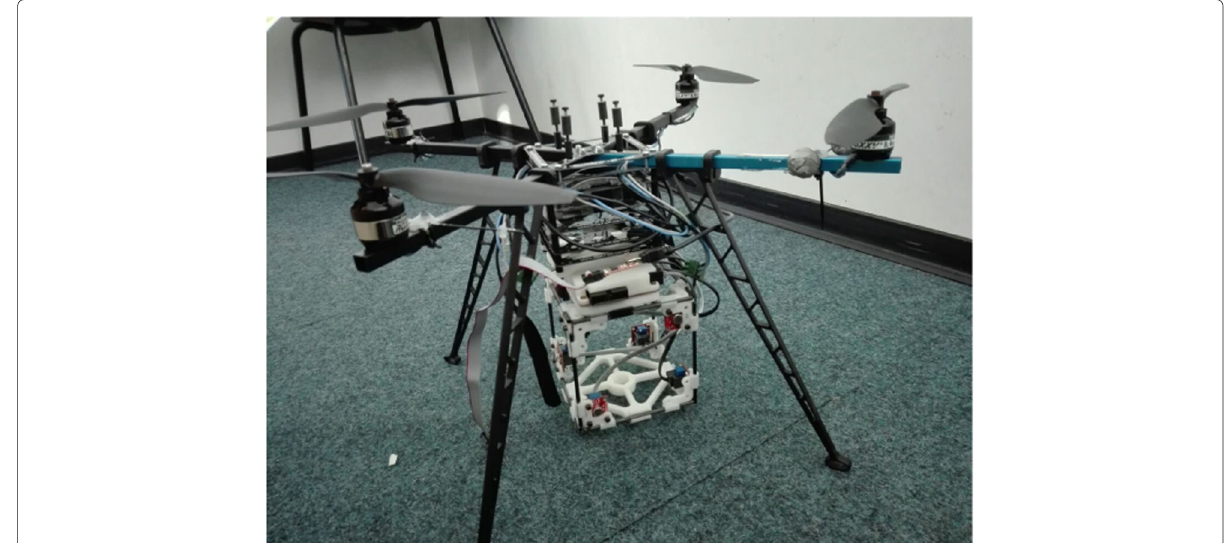
Fig. 6 Audio recording UAV overview. Image provided by SPCup syllabus